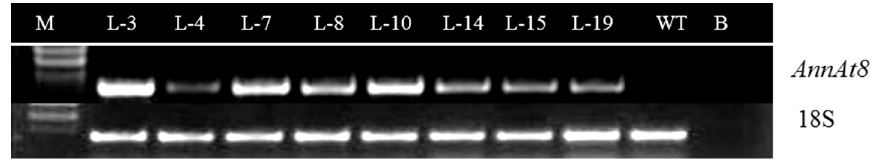
Figure 1. Expression analysis of AnnAt8 by semi-quantitative RT-PCR in AnnAt8 overexpressing transgenic Arabidopsis plants confirmed at T 1 generation. WT is taken as a non-transgenic control, B is non-template control. 18S used as reference gene.